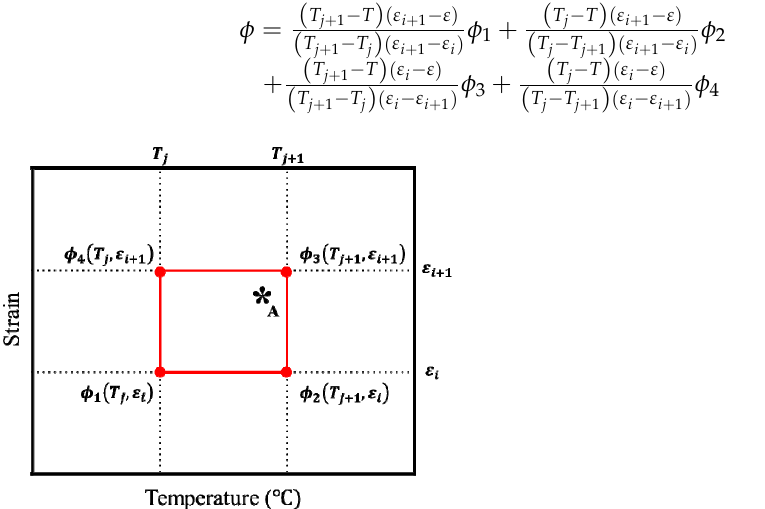
Figure 19. Piecewise bilinear expression of material constants using the sample grid points in the form of φ (strain, temperature) [142,143].